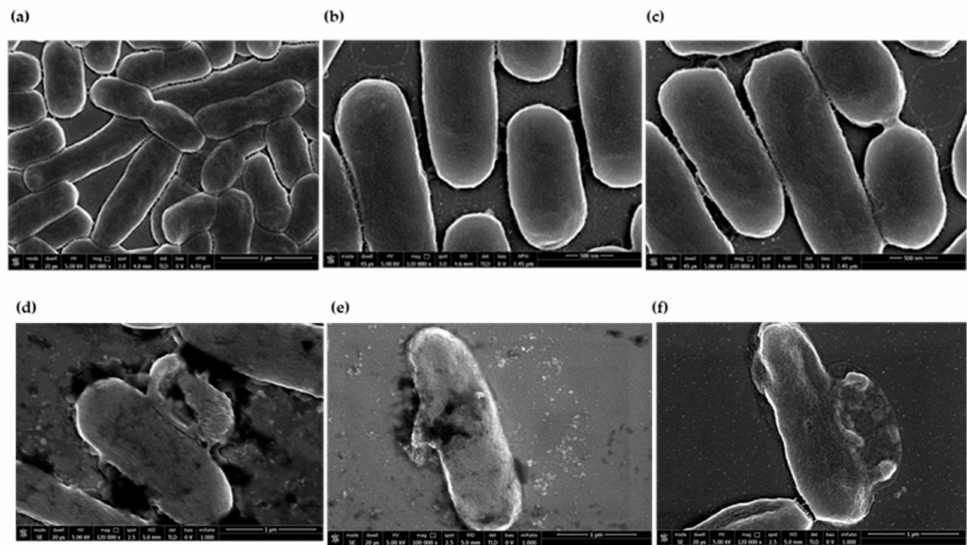
Figure 7. Scanning electron microscopy of E. coli BL 2 1 cells following 3 h treatment with a sub-mic concentration (9 µ M) of the antimicrobial peptide C-15867 ( d – f ) in comparison with untreated cells ( a – c ). The scale bar was 2 µ m in panel ( a ), 500nm in panel ( b , c ) and 1 µ m in panel ( d – f